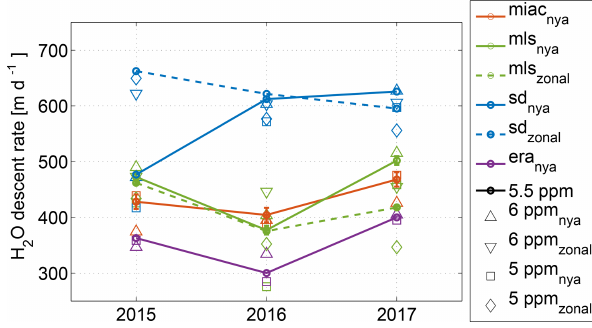
Figure 8. Descent rates of water vapour at Ny-Ålesund calculated from the 5, 5.5 and 6ppm isopleths from MIAWARA-C, MLS, SD- WACCM and ERA5 between 15 September and 1 November for the years 2015, 2016 and 2017. For MLS and SD-WACCM the descent rates of the zonally averaged water vapour are also shown.